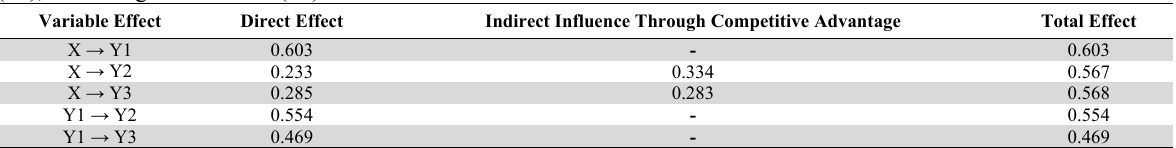
Direct Effects, Indirect Effects, and Total Effects of Product Innovation (X), Competitive Advantage (Y 1 ), Internationalization (Y 2 ), Marketing Performance (Y 3